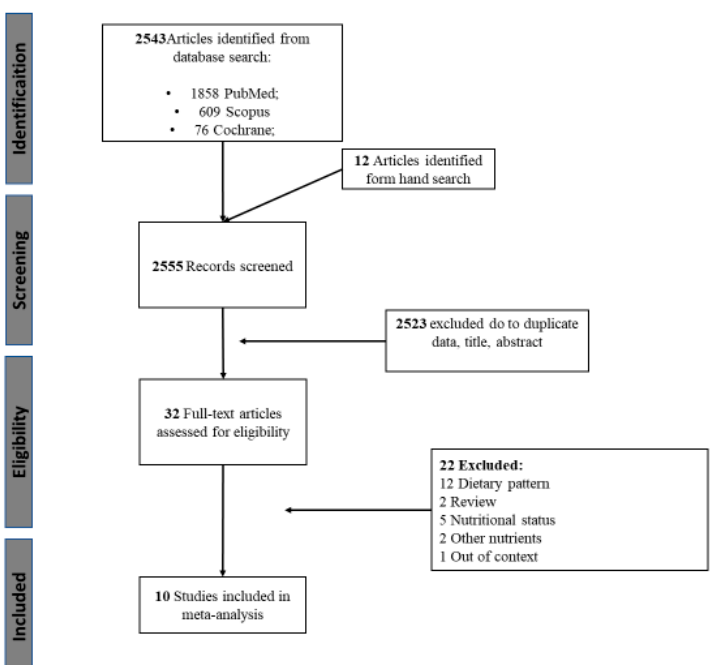
Figure 1. Flow chart of the present study.